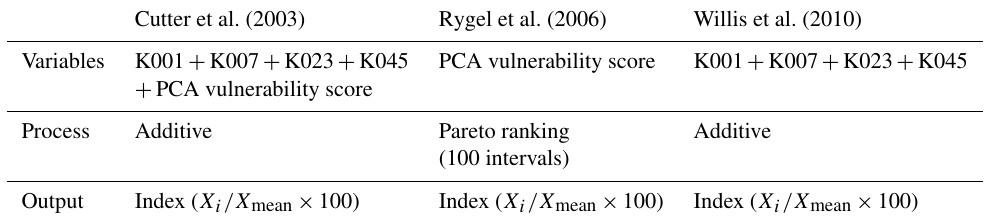
Table 4. Summary of how the social vulnerability index is constructed using the three different methods.